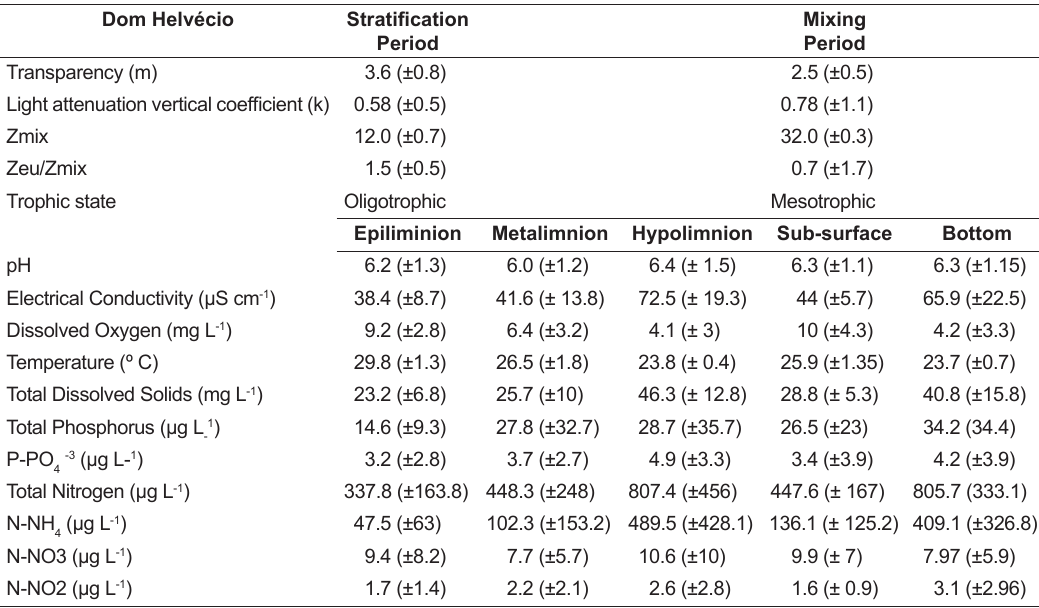
Table 2. Water physical and chemical variables (averages and standard deviations of the five years of Lake Dom Helvécio, Rio Doce State Park, Minas Gerais State, southeast Brazil. Dom